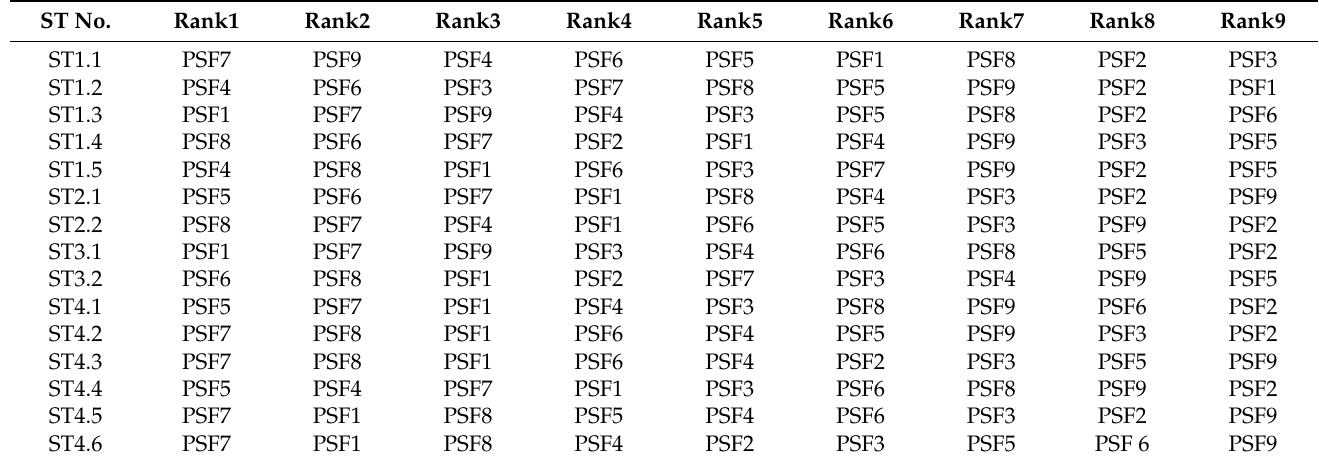
Table 13. Risk-based grey relational degree of each PSF in each ST.